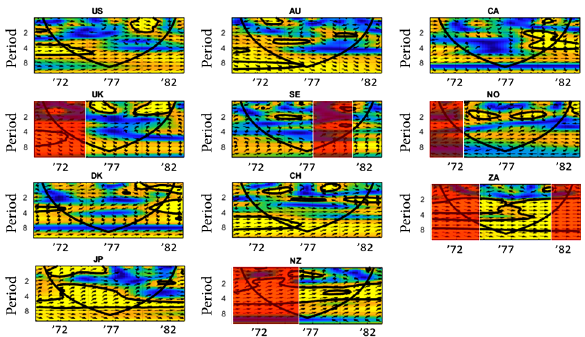
Figure 2. Wavelet coherency between M3 money growth and house price inflation from 1Q 1970 to 4Q 1983 source (own